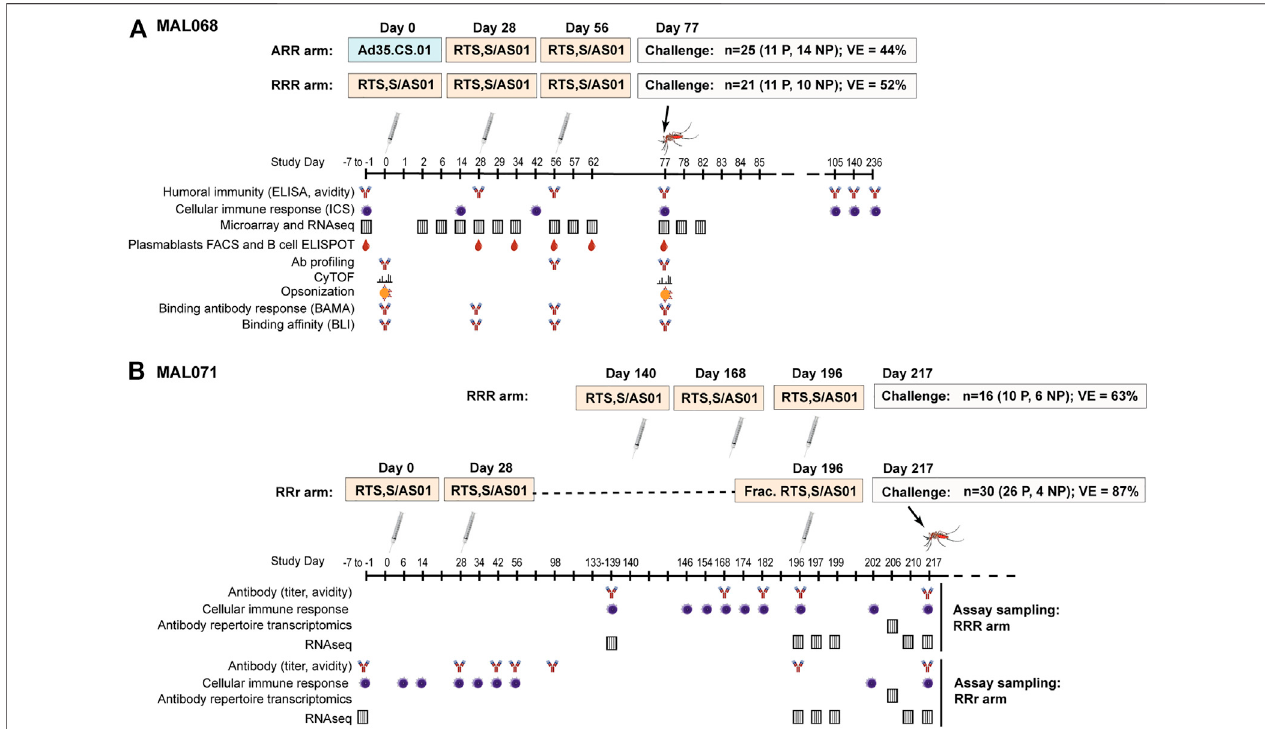
FIGURE1| Schemas,ef fi cacyresults,andsamplingschedulesfortheMAL068andMAL071studies.MAL071studydayspast217(challengeday)arenotshown, but follow-up continued until Day 376.